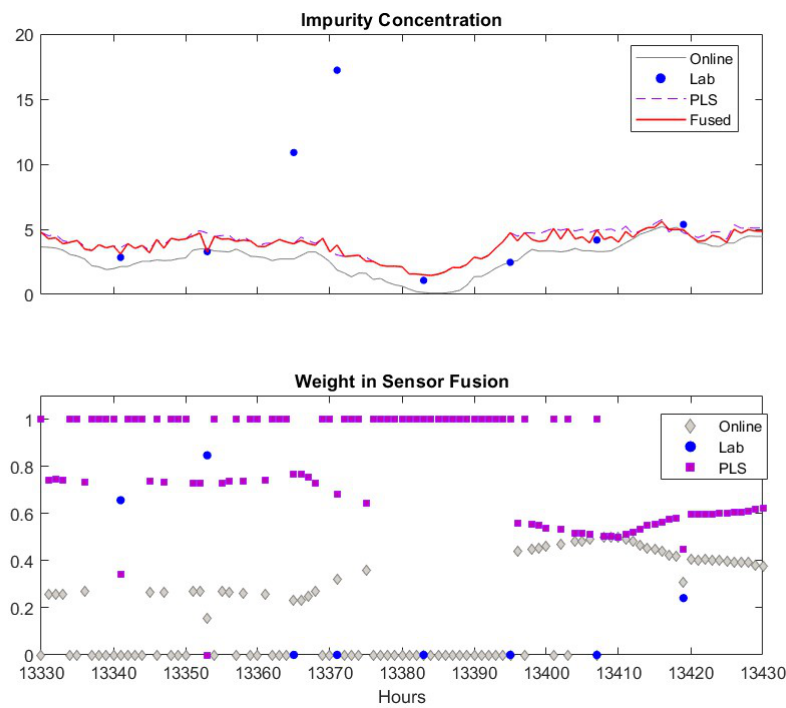
Figure 11. An example when lab data are spurious. Upper figure: Comparisons of lab data (●), online analyzer data (–), PLS software sensor data (–) and fused value (–). Lower figure: Weights of lab data (●), online analyzer data ( ♦ ), PLS software sensor data ( ■ ).